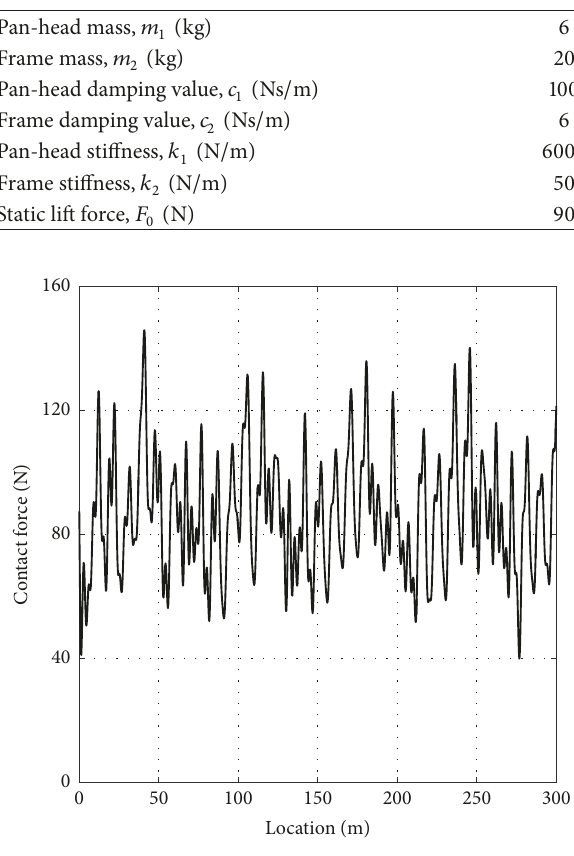
Figure 14: Contact forces at a speed of 160km/h.